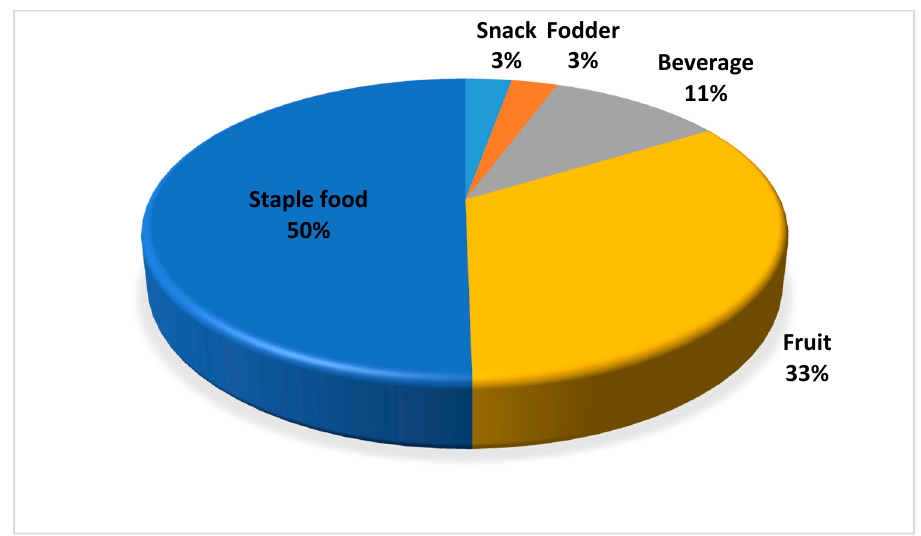
Figure 2. Use-categories for indigenous and naturalized plants among the 133 rural households in North West Province, South Africa (n = 36).